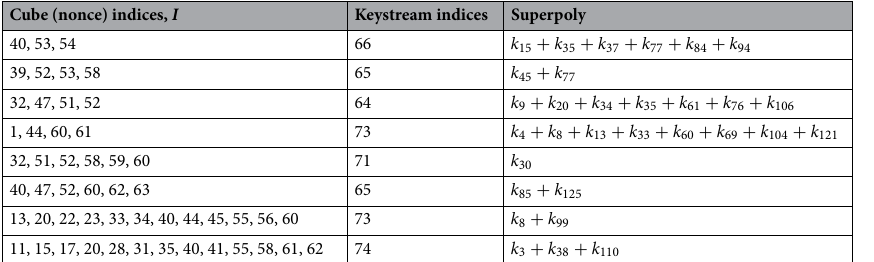
Cube size l c Cube (nonce) indices,